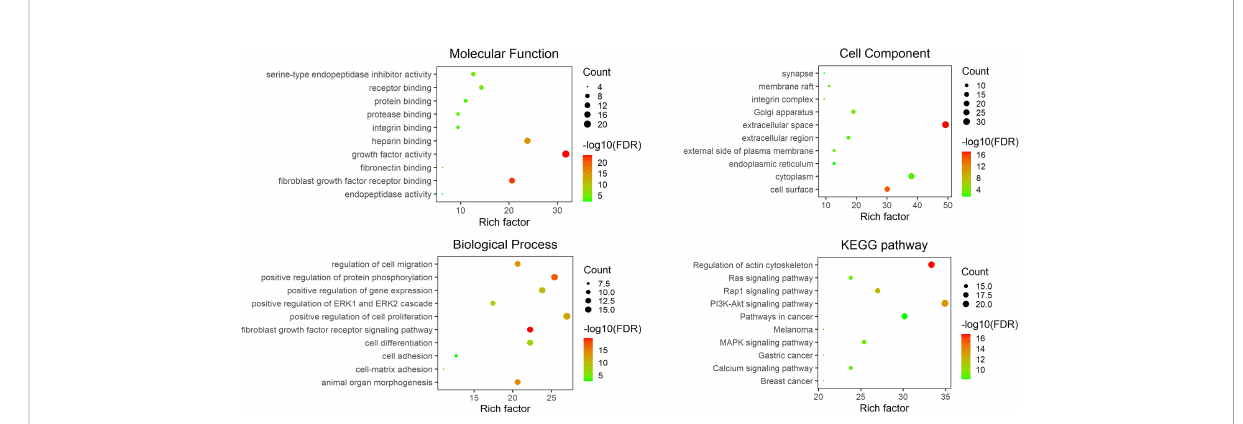
FIGURE 2 The GO and KEGG analysis results of related components of the host adhesin binding protein interaction network. The fi gure shows the top ten entries with an FDR of less than 0.05. The ordinate represents the GO annotation entry or KEGG pathway name, and the abscissa is a rich factor. The number of enrichment genes is associated with bubble size, and the statistical signi fi cance is associated with bubble